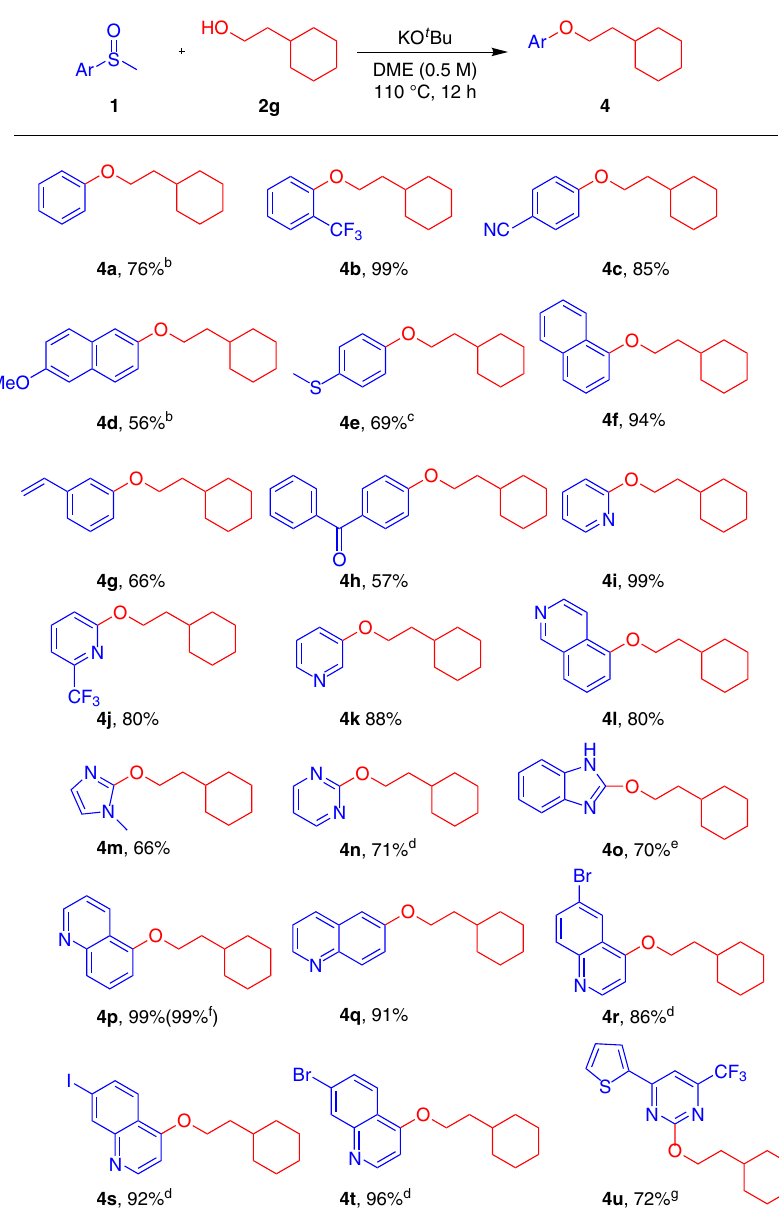
Fig. 3 Substrate scope of aryl methyl sulfoxides with 2g a . a Unless noted, all reactions were conducted with 1 (0.2 mmol), 2 g (0.4 mmol), KO t Bu (0.4 mmol) in DME (0.4 mL) under argon atmosphere at 110 °C for 12 h. b 2g (3.0 equiv), KO t Bu (3.0 equiv) at 110 °C for 24 h. c 2g (3.0 equiv), KO t Bu (3.0 equiv). d 40 °C; e 2g (3.0 equiv), KO t Bu (4.0 equiv) at 100 °C for 30 h. f Large scale reaction: 1q (5.5 mmol), 2g (11.0 mmol), KO t Bu (11.0 mmol) in DME (11.0 mL) under argon atmosphere at 110 °C for 12 h. g 1u (4.0 equiv), 2g (1.0 equiv), KO t Bu (2.0 equiv) at 40 °C for 48 the B3LYP level of theory with 6-31 + G(d) basis set for all atoms. Single point energies and solvent effects in 1,4-dioxane were computed at the M06-2X level of theory with 6-31 + G(d,p) basis set for all atoms, using the gas-phase optimized structures. Sol- vation energies were calculated by a self-consistent reaction fi eld (SCRF) using the SMD solvation model.